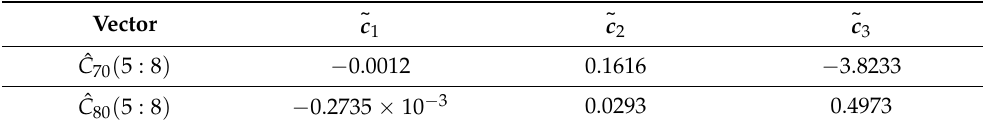
( 5 : 8 ) parameters’ values (procedure 1